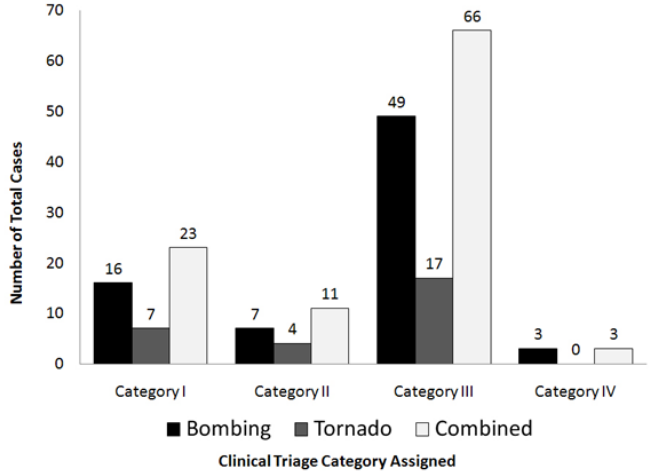
Figure. Distribution of mass casualty-disaster cases by clinical triage category and event